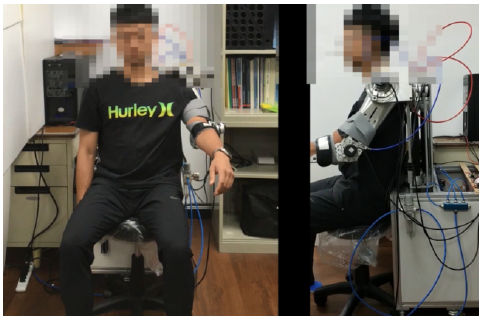
Figure 10. Rehabilitation on shoulder joints J 1 , J 2 and elbow joint J 4 .